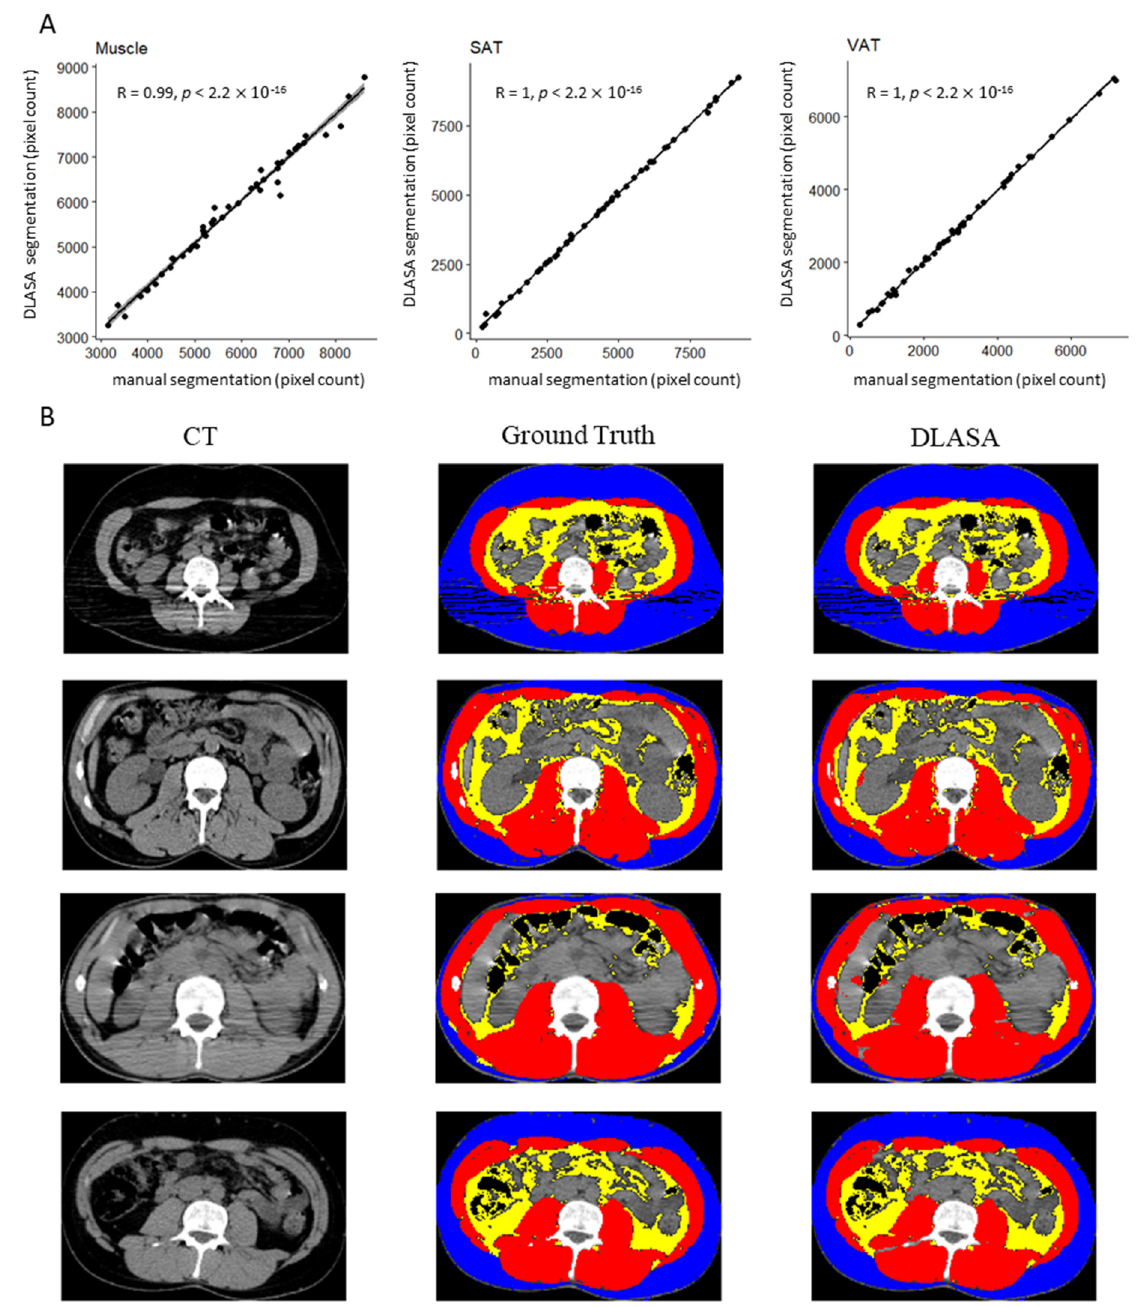
Figure 1. ( A ) Correlation between manual segmentation and DLASA segmentation. ( B ) Visual rendering of manual (ground truth) and automated (DLASA) segmentation. DLASA: Deep Learning automated segmentation algorithm. SAT: subcutaneous adipose tissue (blue). VAT: visceral adipose tissue (yellow). Muscle region of interest (red).